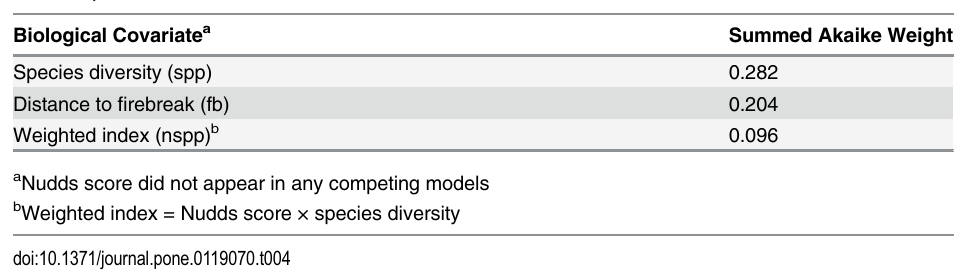
Table 4. Summed Akaike weights (from competing models) for each biological covariate affecting neonatal white-tailed deer survival in the fi rst 10 days of life at Fort Bragg Military Installation, North Carolina, 2011 –